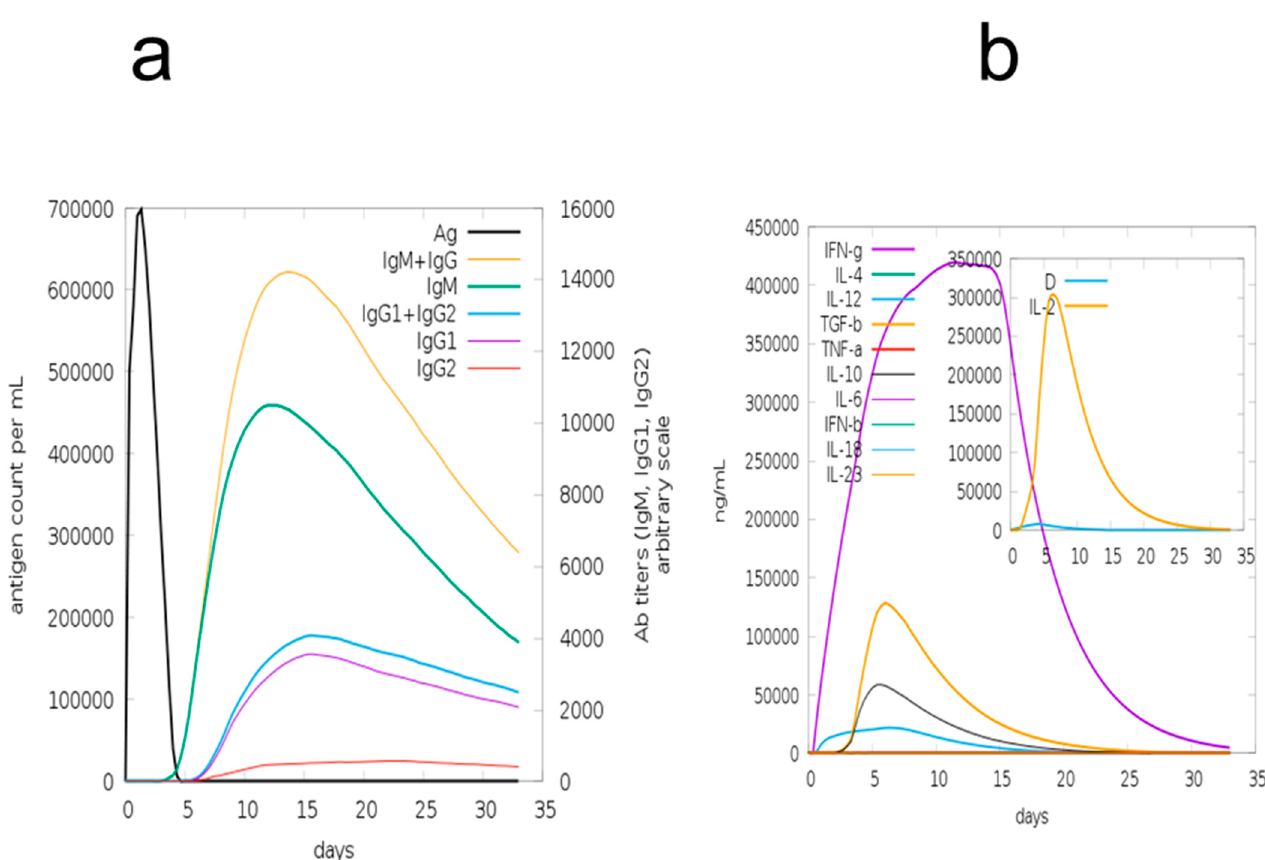
Figure 7. In silico immune reactions of multiple epitope-based vaccines from an antigen: ( a ) development of interleukins and cytokines; ( b ) immunoglobulin generation and isotopes of B-cells following exposure to the antigen in different states on the Simpson